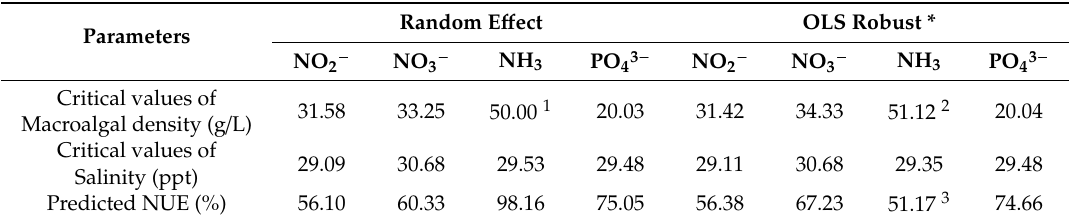
Critical values of macroalgal density and salinity and the corresponding predicted maximum